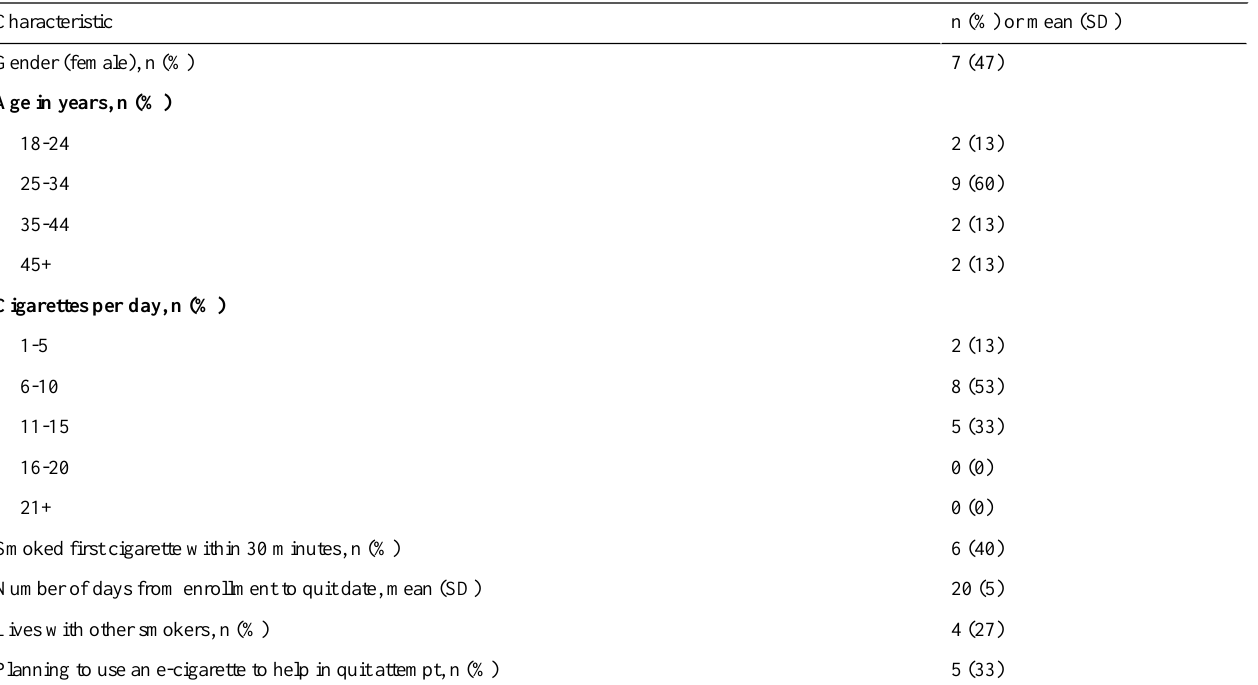
Table 1. Participant characteristics